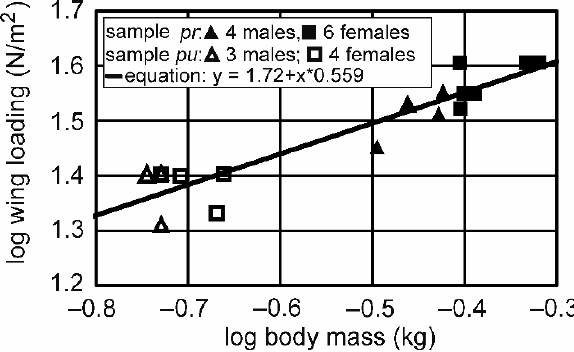
Figure 3. Scaling of wing loading with body mass. The solid black line indicates the linear relation